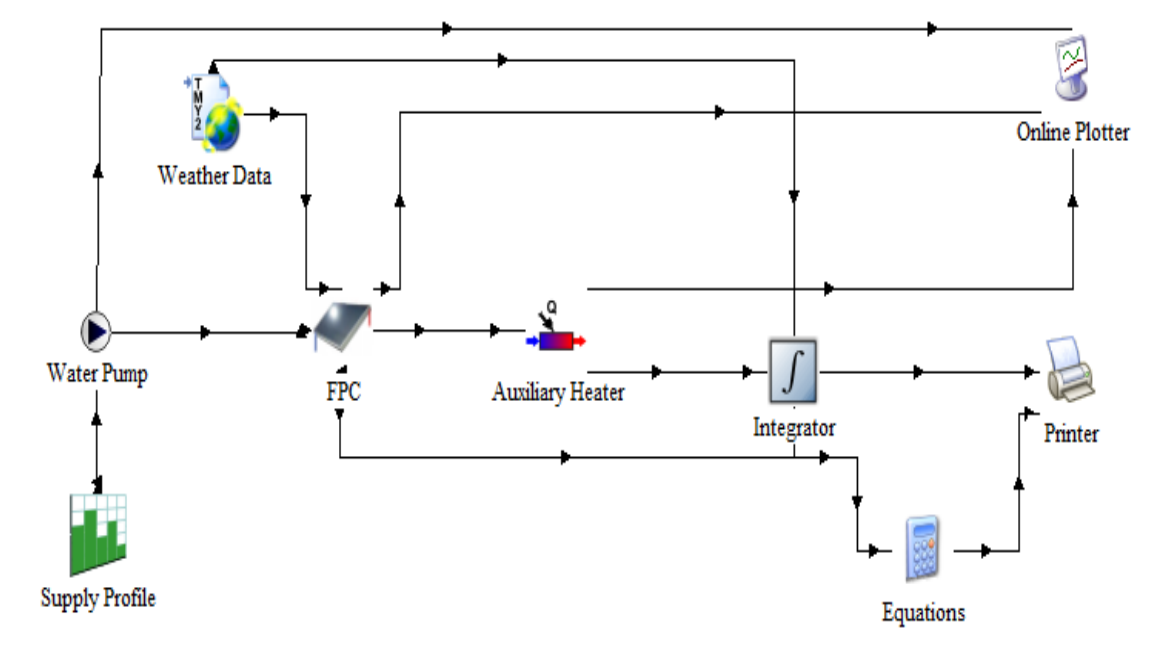
Figure 3. TRNSYS model of FPC-based SIPH plant.